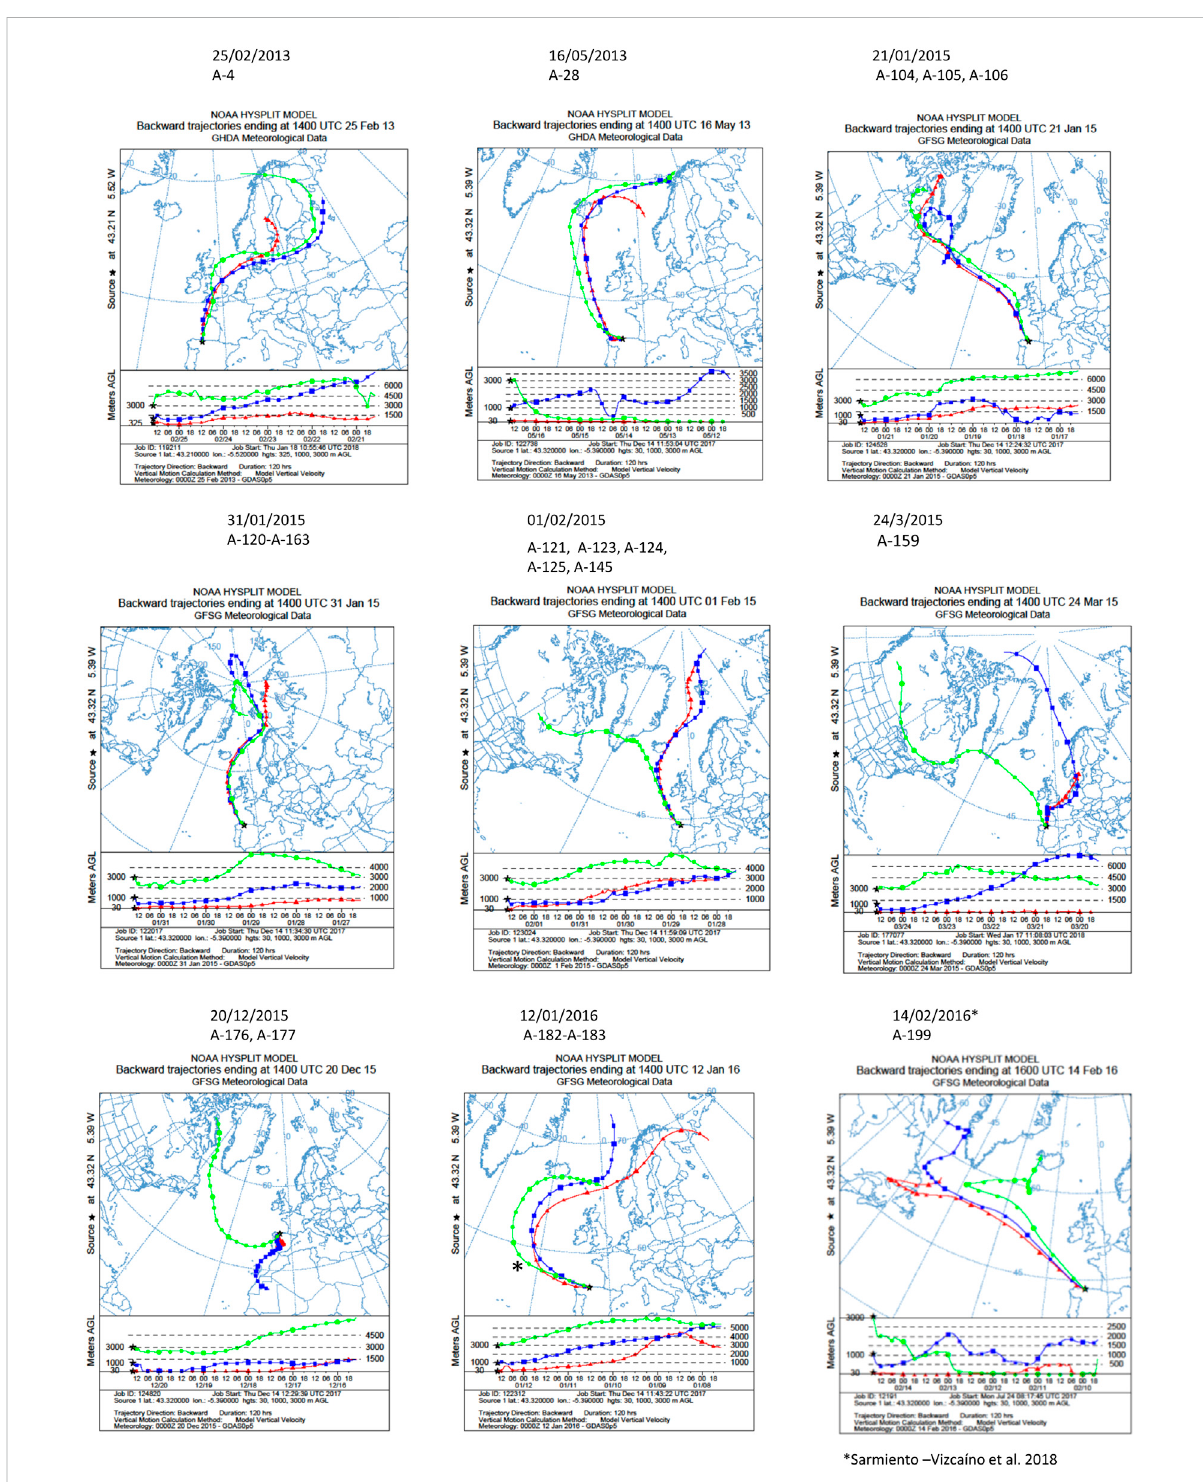
FIGURE 2 Five-day backward trajectories of air masses generating the storms that caused the precipitation events. They were calculated with the NOAA HYSPLIT Model with three different transects with different arriving height as previously reported (Sarmiento-Vizcaíno et al., 2018). The sampling locations were used as the backward trajectory start point with altitudes over sea level of 30, 1,000 and 3,000 m (Gijón), 300, 1,000 and 3,000 m (Oviedo). Black asterisks indicate the sampling places. The strains isolated and the dates of the precipitation events are shown on the top of the fi